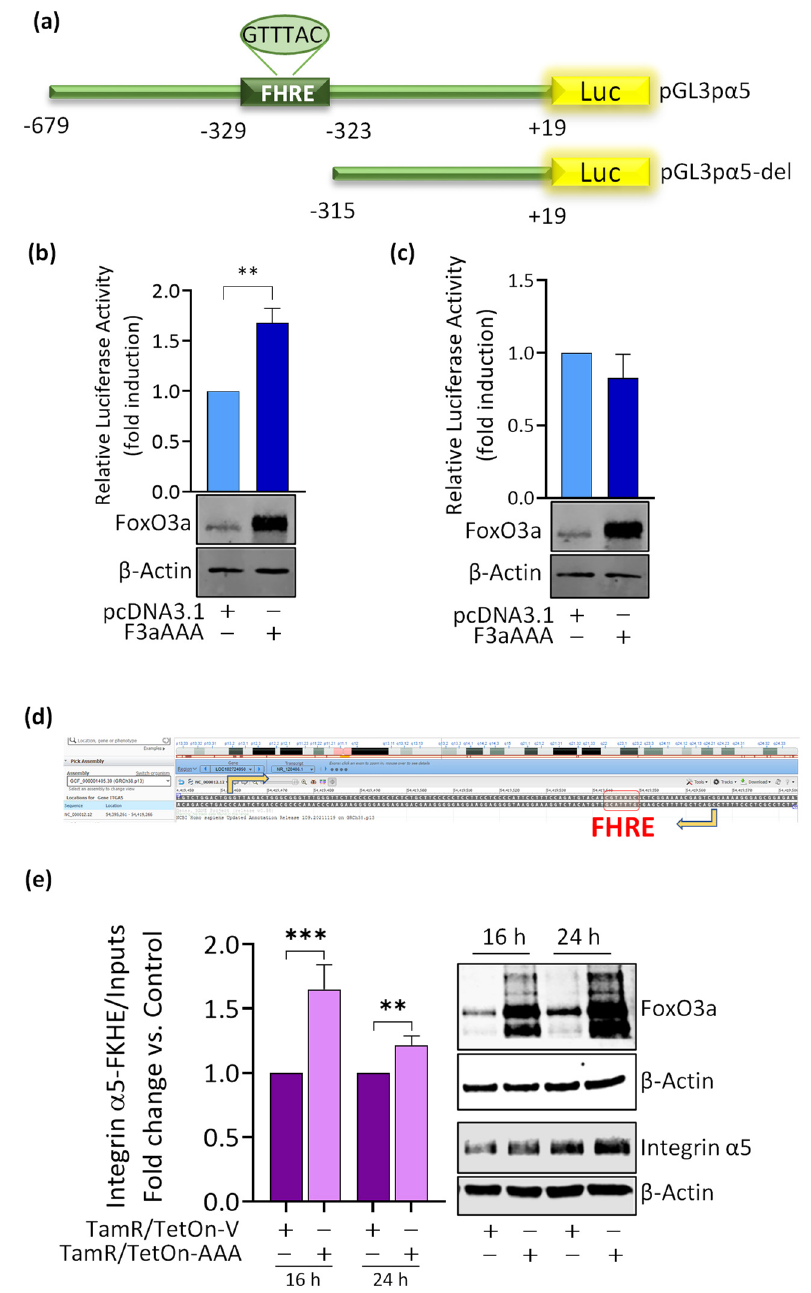
Figure 4. FoxO3a binds to and transactivates the human integrin α 5 promoter. ( a ) Schematic representation of the human integrin α 5 promoter plasmid (pGL3p α 5) and the FHRE deleted fragment (pGL3p α 5-del). The constructs contain the same 3 ′ -boundary (+19), while the 5 ′ -boundaries of the promoter were − 679 and − 315, respectively. ( b , c ) Transcriptional activity of integrin α 5 promoter fragments following FoxO3a overexpression is shown. TamR cells (7 × 10 4 /well) were co-transfected in suspension either with pcDNA3.1 or F3aAAA vectors (0.5 μ g/well) and seeded in GM on 24-well plates. After 36 h, a second transfection with pGL3p α 5 ( b ) or pGL3p α 5-del ( c ) plus pRL-Tk plasmid occurred. The next day, the firefly luciferase activity was detected. Data obtained from at least three independent experiments were normalized to the activity of the pRL-Tk and expressed as relative luciferase activity (fold induction over control). FoxO3a expression in transfected samples was analyzed by WB on total lysates from the same set of cells. ( d ) A screenshot from NCBI genome data viewer illustrating FHRE location in the 5 ′ flanking region of the ITGA5 gene. FHRE motif is indicated by a red box and goes from position 54419543 to 54419550 in the negative strand. For ChIP analysis, the FHRE-containing DNA region, spanning